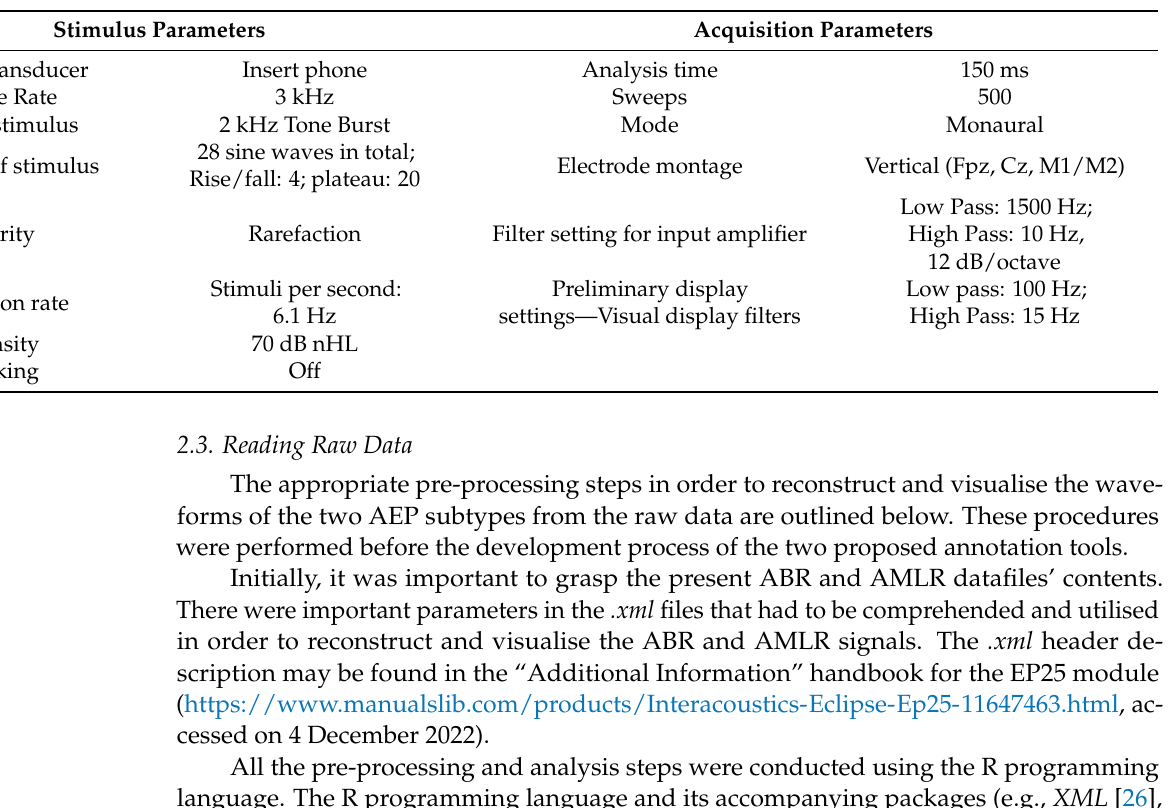
Table 2. Stimulus and acquisition parameters for AMLR